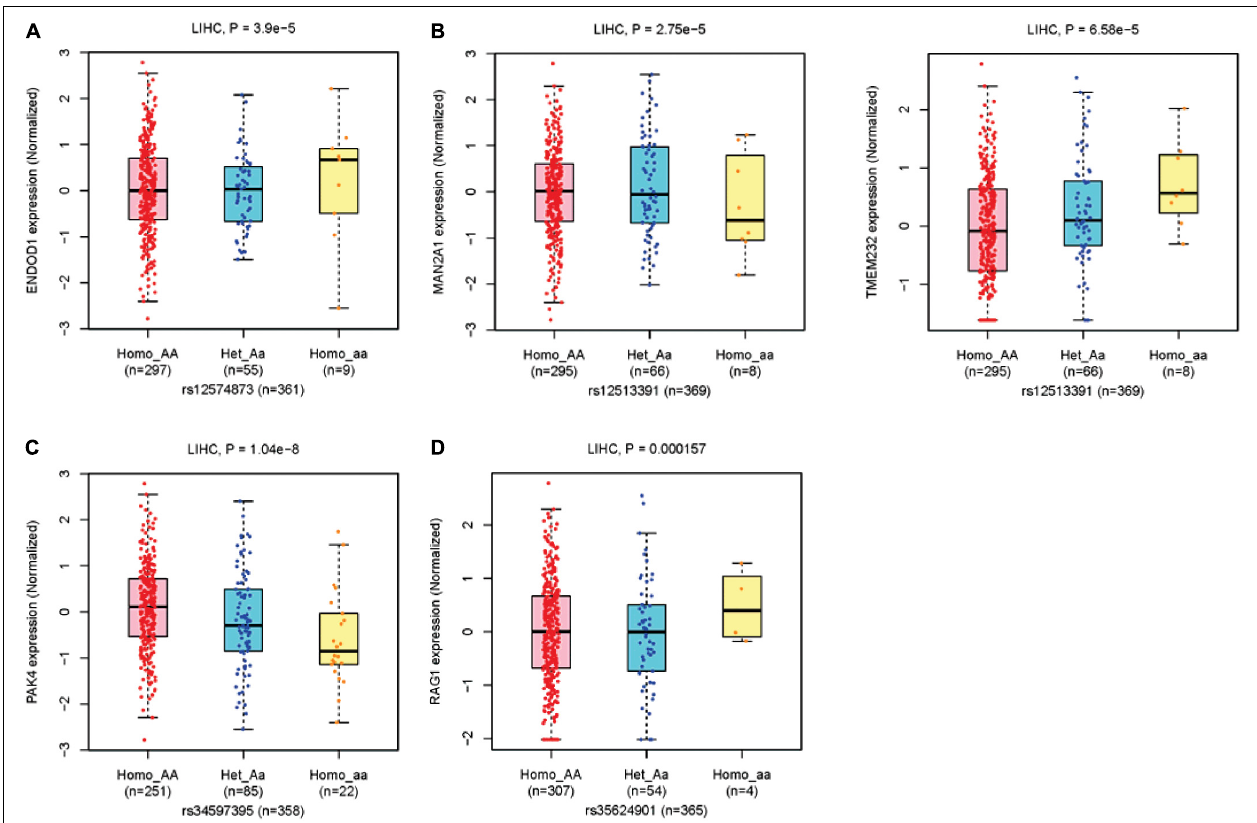
FIGURE 3 | The boxplots of TCGA LIHC eQTLs. (A) The ENDOD1 expression levels grouped by different genotypes of rs12574873. (B) The MAN2A1 (left panel) and TMEM232 (right panel) expression levels grouped by different genotypes of rs12513391. (C) The PAK4 expression levels grouped by different genotypes of rs34597395. (D) The RAG1 expression levels grouped by different genotypes of rs35624901.